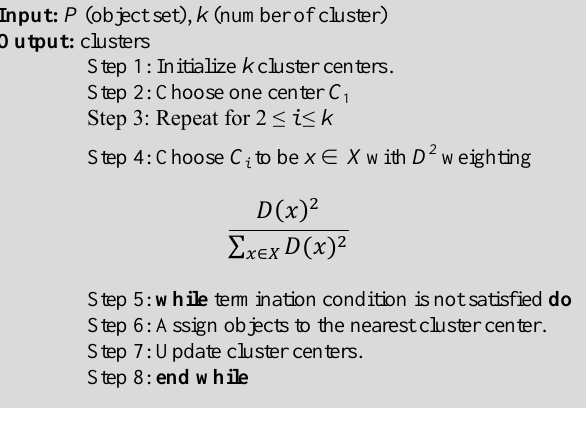
Figure 1. k -means++ workflow.